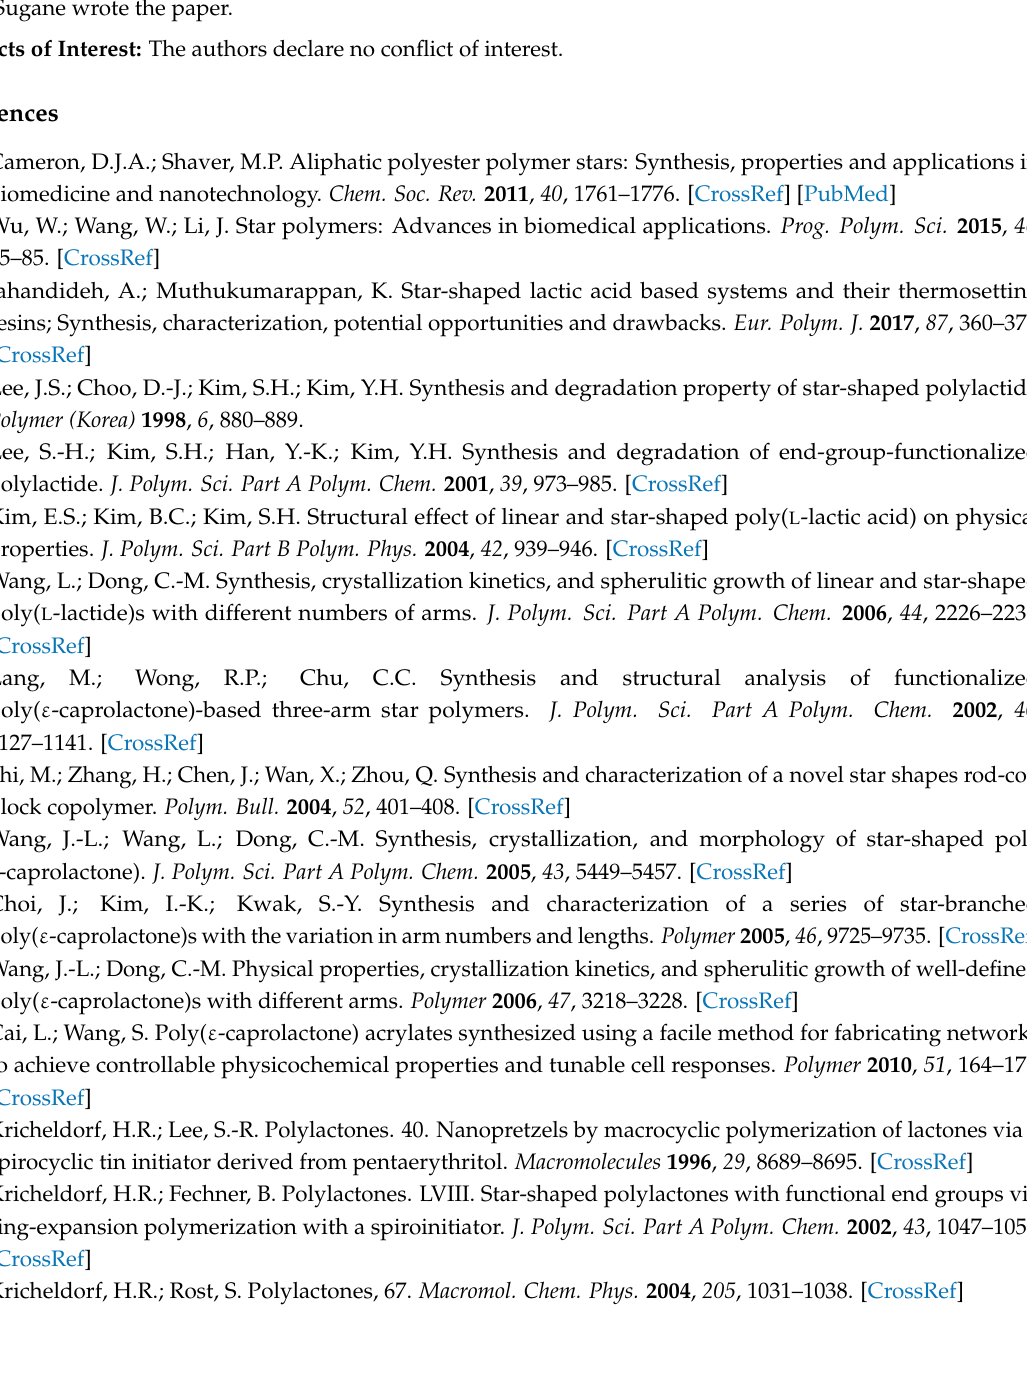
Figure S8: XRD patterns of H6SLLAO, H6SDLAO, H3SCLO, SPN-6LLAO and SPN-6cLAO/3CLOs 100/0, 75/25, 50/50, 25/75, 0/100, Figure S9: The first and second heating DSC curves for H5SLLAO, H5SDLAO, H3SCLO, SPN-5LLAO and SPN-5scLAO/3CLOs (100/0, 75/25, 50/50, 25/75 and 0/100), Figure S10: Polarized optical microscope images of the SPN-4scLAO/CLOs 100/0, 75/25, 50/50 and 25/75 held at a specified temperature for 10 min after melted at 220 ◦ C, Figure S11: Polarized optical microscope images of the SPN-6scLAO/CLOs 100/0, 75/25, 50/50 and 25/75 held at a specified temperature for 10 min after melted at 220 ◦ C, Figure S12: FE-SEM images of the fractured surfaces of SPN- m scLAO/3CLO 75/25–25/75 conetworks ( m = 4, 5 and